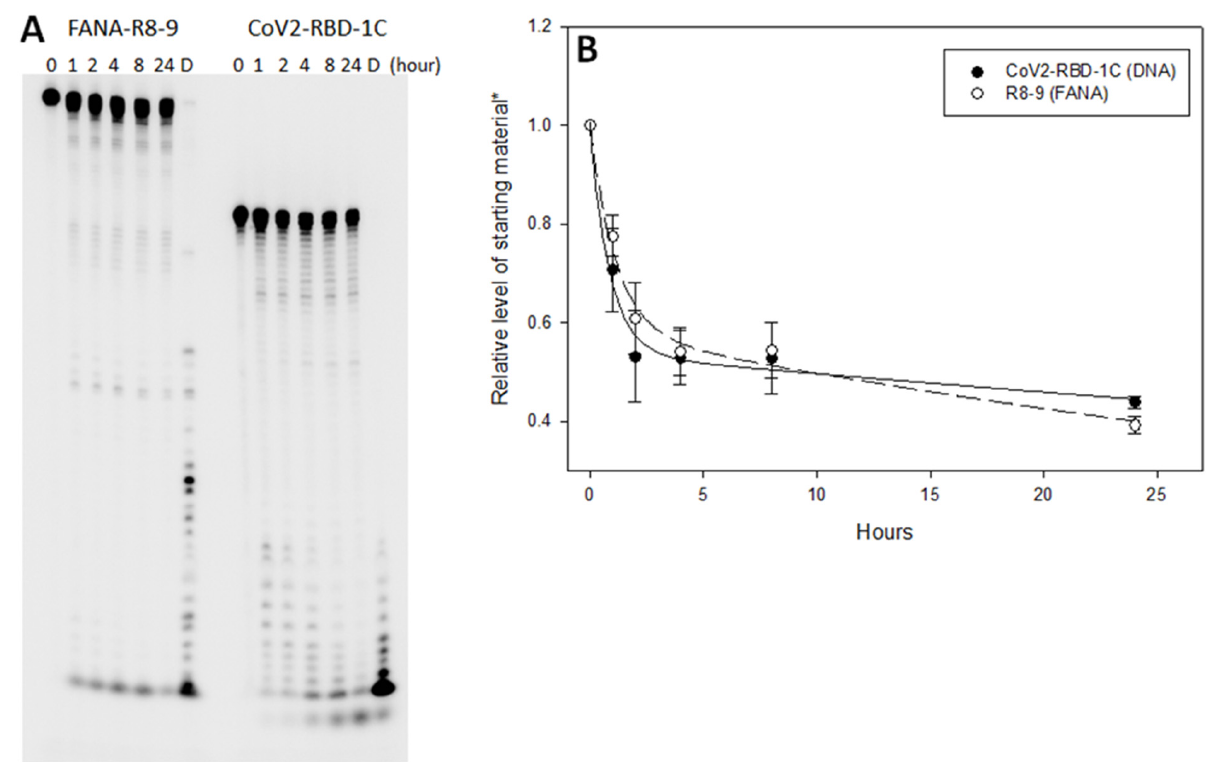
Figure 6. ( A , B ). Aptamer stability assay. 100 nM of radiolabeled FANA-R8–9 (79 nts) and DNA aptamer CoV2-RBD-1C (51 nts (46)) were incubated in 200 uL of D-MEM complete + 10% FBS, and 1% penicillin/streptomycin) at 37 ◦ C. Twenty ul aliquots were removed at 0, 1, 2, 4, 8, and 24 h time points and run on a 10% PAGE denaturing gel. Lane ‘D’, a 20 uL aliquot was digested with DNaseI for 30 min at 37 ◦ C as a control; ( B ) quantification of products. Gels were visualized and quantified using a phosphorimager. The level of full-length undegraded material was measured at each time point. The graph shows averages from three independent experiments with error bars representing the standard deviations. * Values were relative to the amount of material at time 0.